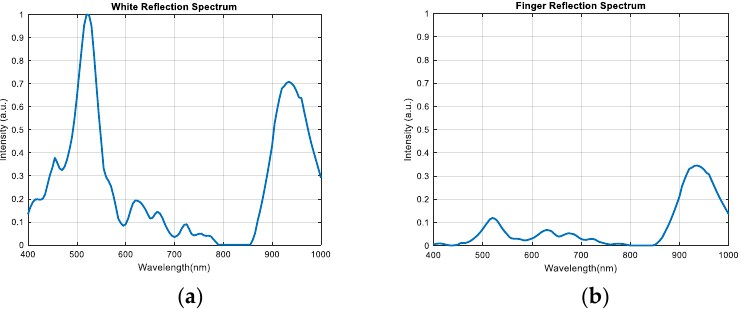
Figure 6. Reflection spectrum: ( a ) on a standard reflection white plate; ( b )on a finger.